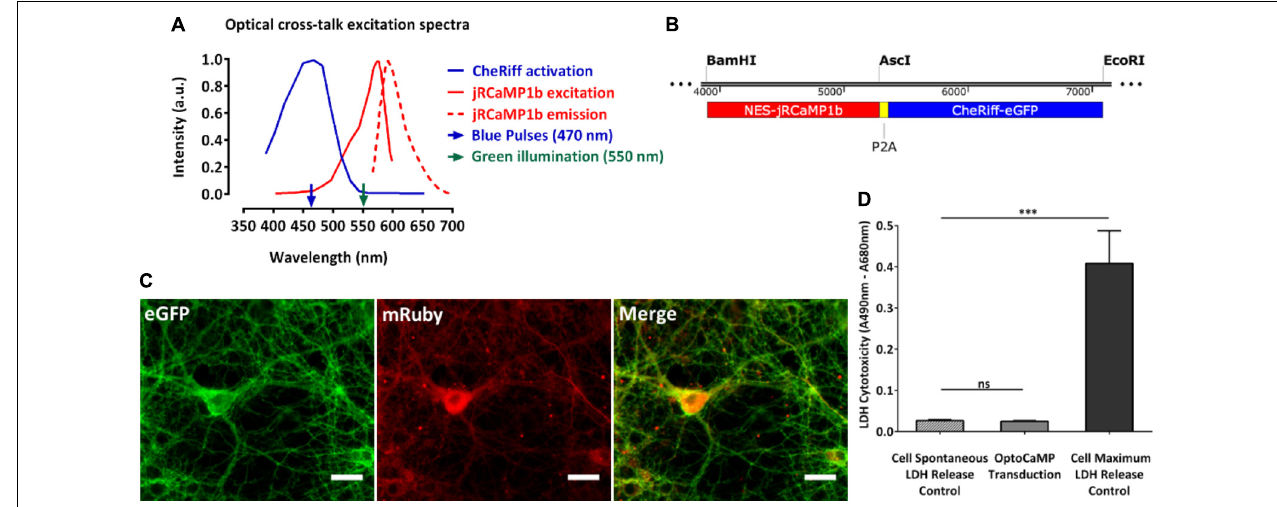
FIGURE 1 | OptoCaMP enables simultaneous stimulation and calcium recording in neuronal dissociated cultures. (A) Activation spectrum of CheRiff (blue) and excitation/emission spectra of jRCaMP1b (red). The green and blue arrows, respectively, indicate the continuous green illumination at 550 nm and the blue pulses at 470 nm. (B) Schematic of OptoCaMP, bicistronic lentiviral construct designed for the stoichiometric co-expression of the Genetically Encoded Calcium Indicator (GECI) jRCaMP1b (red box) and the Channelrhodopsin variant CheRiff (blue box) to enable simultaneous stimulation and calcium imaging. (C) Single channels and merged fluorescence images of rat cortical neurons expressing OptoCaMP at 14 days in vitro: CheRiff-eGFP is displayed in green and mRuby based GECI jRCaMP1b in red. Scale bar 25 µ m. (D) Quantification of lactose dehydrogenase levels (LDH) in primary cortical neurons 6 days after transduction with the OptoCaMP. The lentivirus delivery did not show any significant difference between the cells non-transduced (cell spontaneous LDH release control) and the cell transduced with OptoCaMP. ( w = 3, one-way ANOVA, F (2,6) = 69.49, P < 0.0001; followed by Tukey’s multiple comparisons test: OptoCaMP transduction versus Cell spontaneous LDH release control, P = 0.992; Cell maximum LDH release control versus Cell spontaneous LDH release control, ∗∗∗ P < 0.0001; Cell maximum LDH release control versus OptoCaMP transduced, ∗∗∗ P <